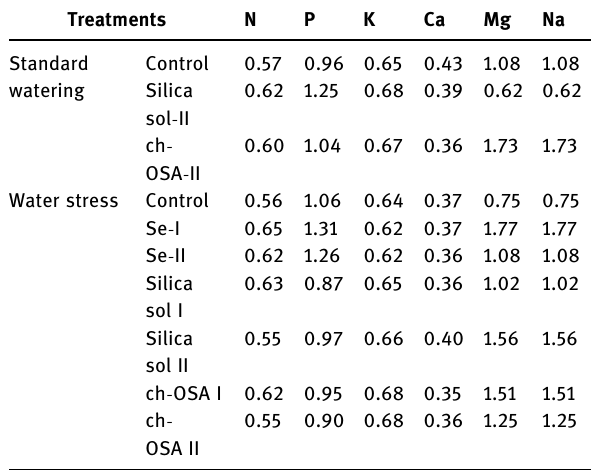
Table 6: The in fl orescence - to - shoot ratio of the content of macro - nutrients and sodium Treatments N Standard